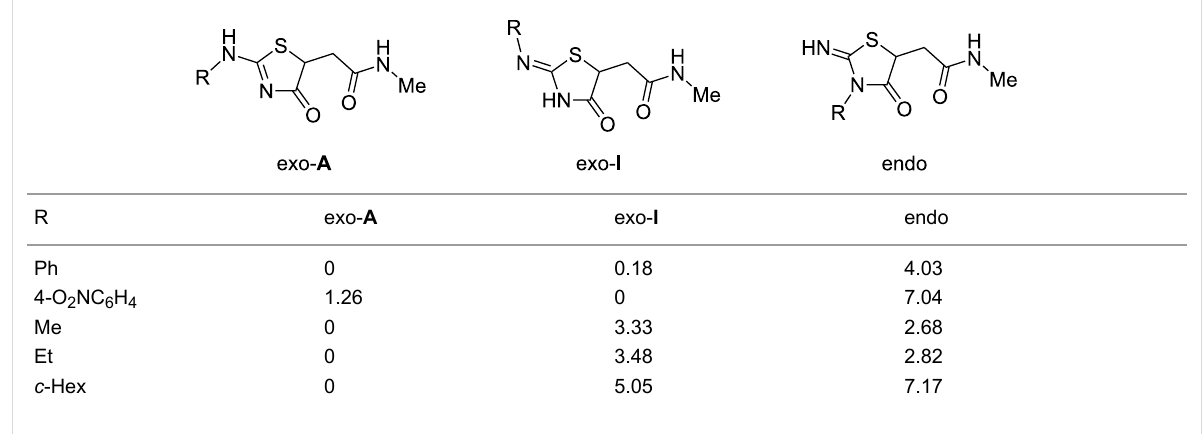
Table 3: Relative Gibbs free energies of the optimized conformations of model thiazolidines, Δ G (kcal/mol) [DFT B3LYP/6-31+G(d,p)), 298 K, DMSO (PCM)].